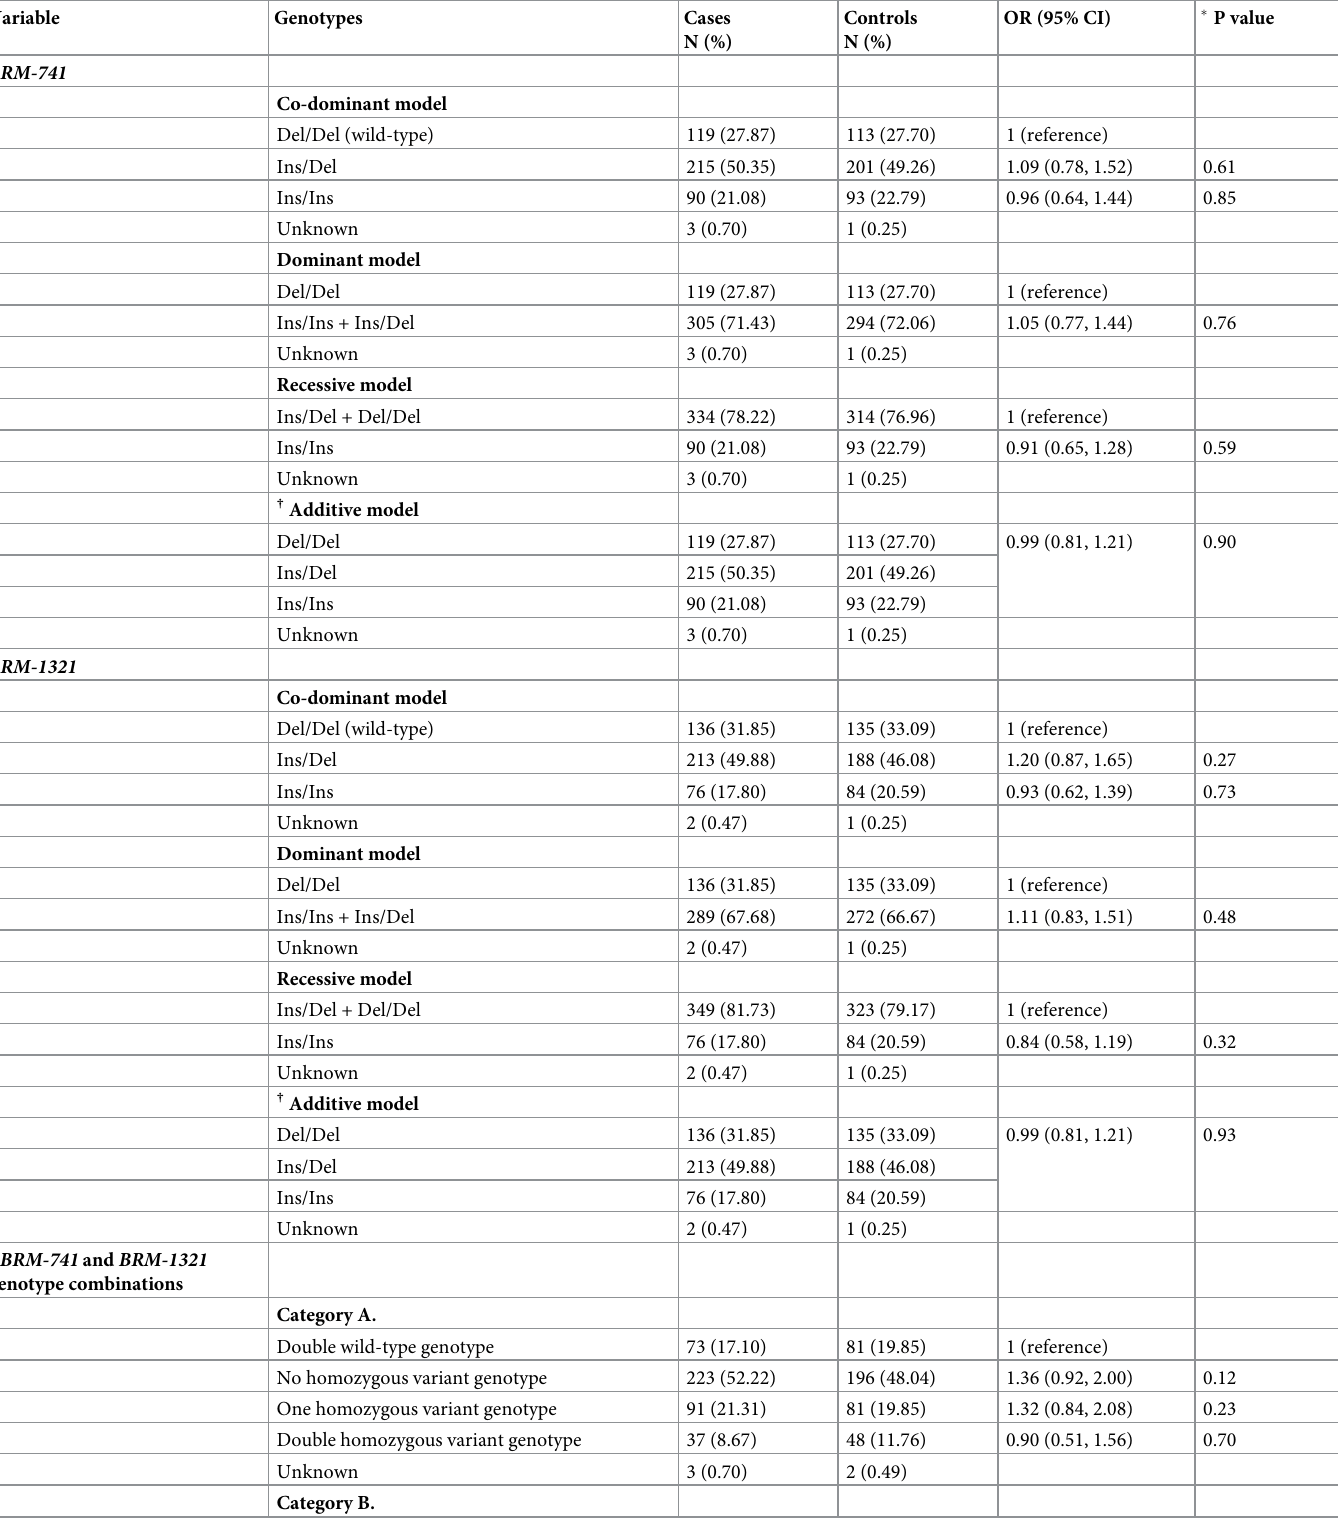
Table 2. BRM promoter indels and colorectal cancer